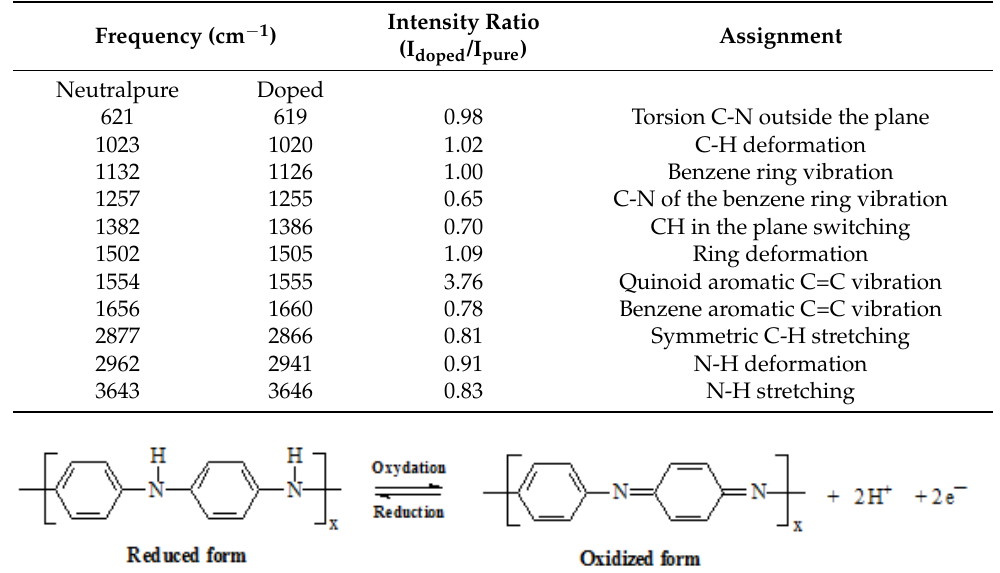
Table 1. FTIR vibrational modes of PANI in both pure and doped states.